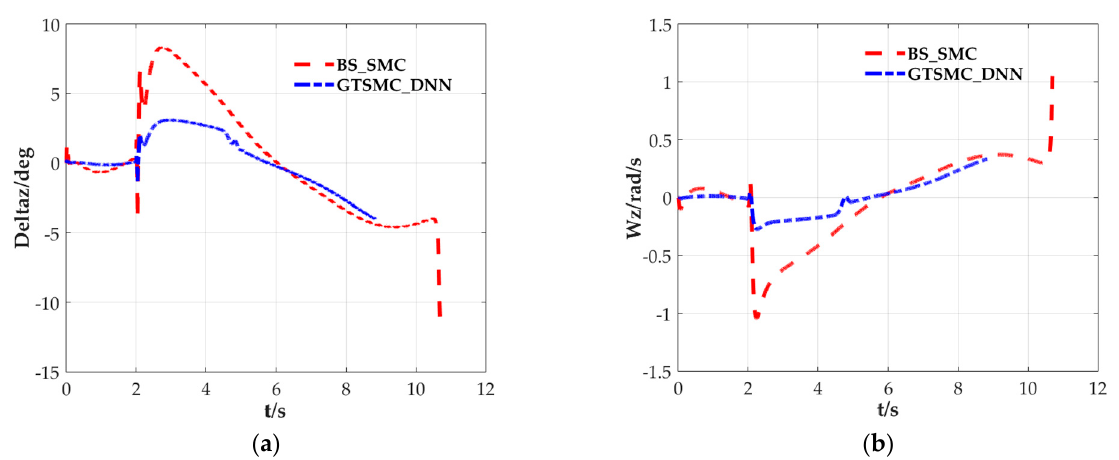
Table 4. The Monte Carlo parameters under case III.